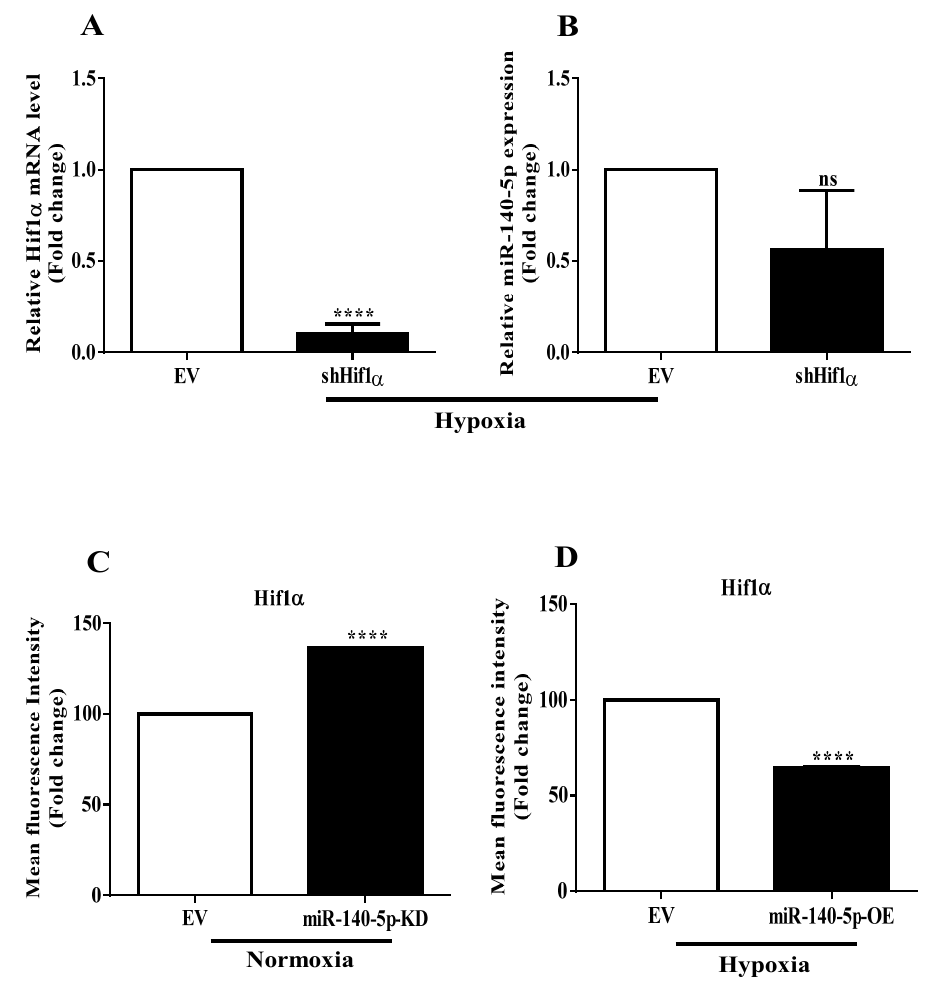
Figure 3. Crosstalk of miR-140-5p and Hif-1 α . ( A ) Hif-1 α expression was transiently inhibited under hypoxia, and relative Hif-1 α mRNA level was measured. ( B ) miR-140-5p expression level was measured in Hif-1 α -inhibited cells. ( C , D ) Effect of miR-140-5p knockdown under normoxia or overexpression under hypoxia on Hif-1 α expression as measured by flow cytometry. Error bars indicate mean ± SEM ( n = 3). Student’s t -tests were used to compare the means of two groups. ns: not significant, **** p < 0.0001 compared to